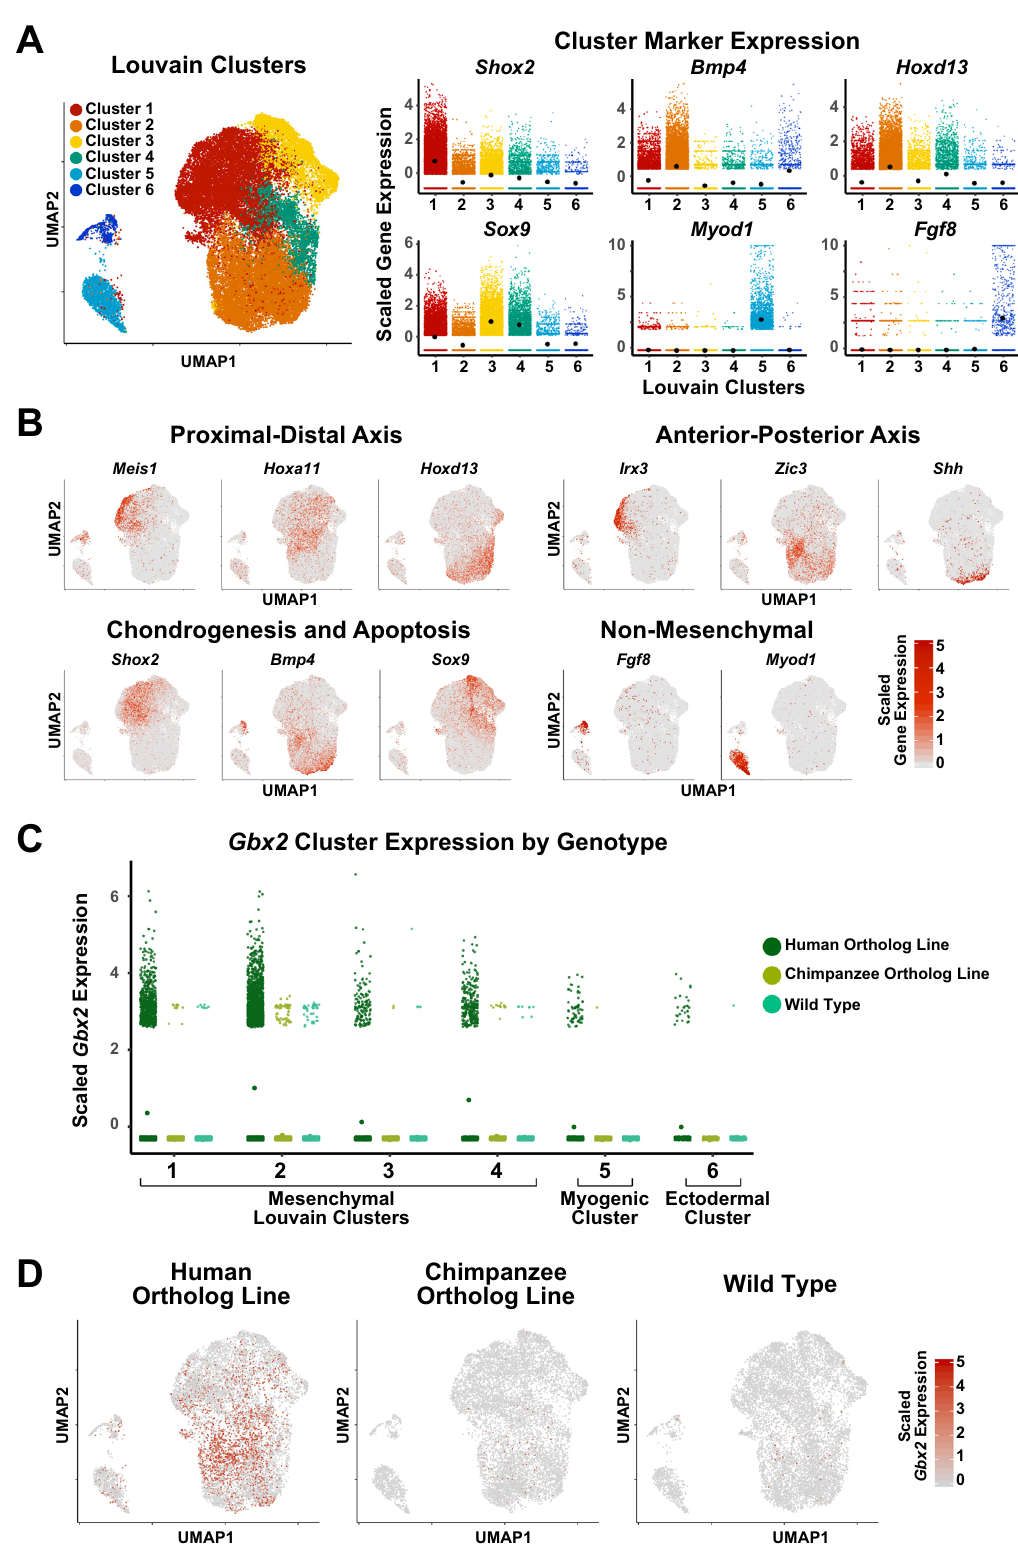
non-mesenchymal cell from chimpanzee ortholog hindlimb and one non-mesenchymal cell from wild type hindlimb was Gbx2- positive (Fig. 4C; Supplementary Data 4). UMAP embedding of cells revealed that Gbx2- positive cells in HACNS1 homozygous hindlimb buds largely clustered within a distinct subset of mesenchymal cells belonging primarily to Louvain clusters 1,